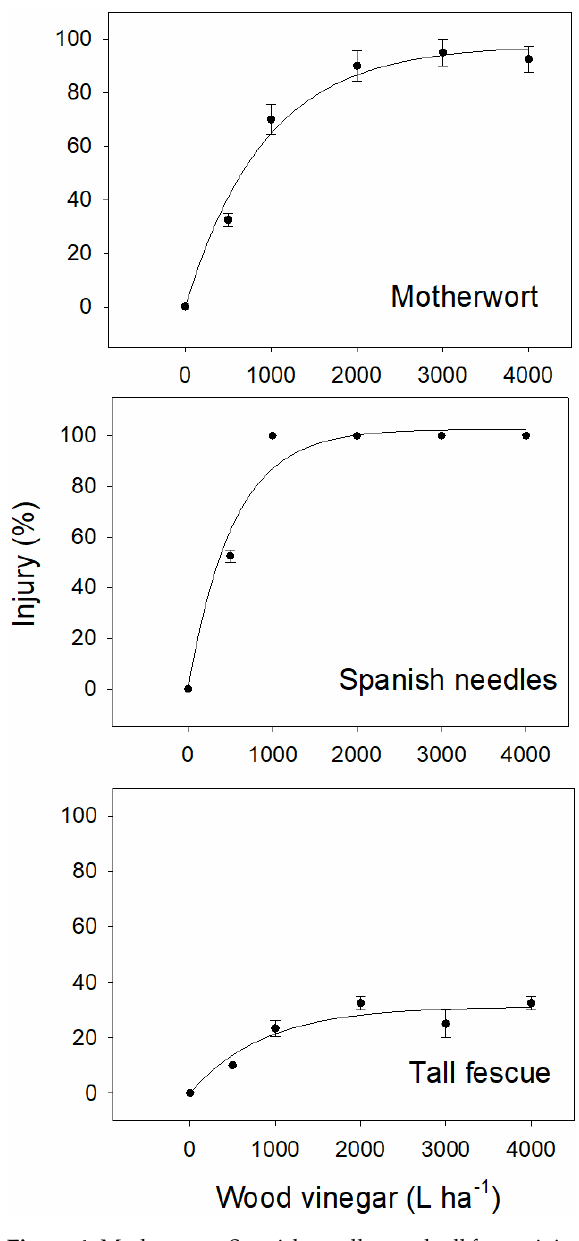
Figure 4. Motherwort, Spanish needles, and tall fescue injury at 10 days after wood vinegar treatments. Vertical bars represent standard errors of the mean ( n = 8).